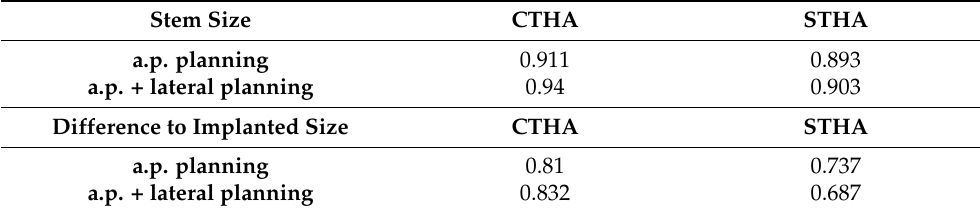
Table 3. The ICC (3,k) with conformity of the values between all three raters.